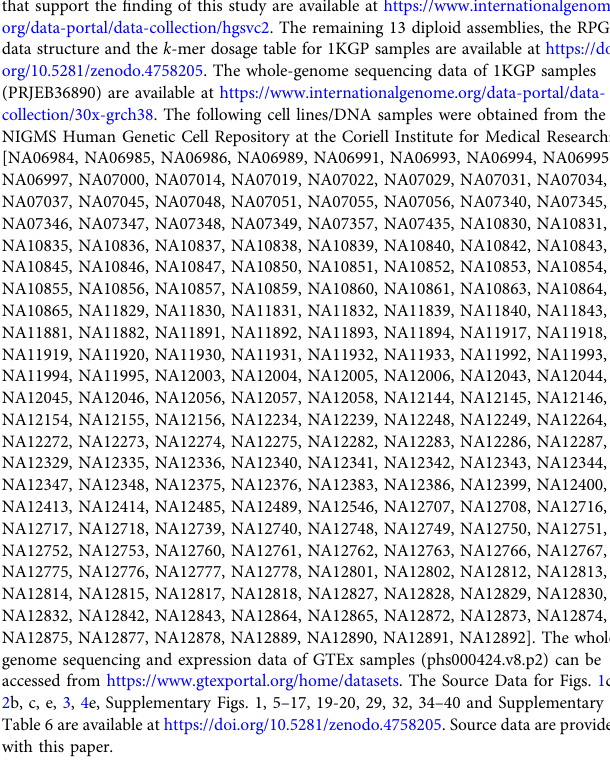
Table 6 are available at https://doi.org/10.5281/zenodo.4758205. Source data are provided with this